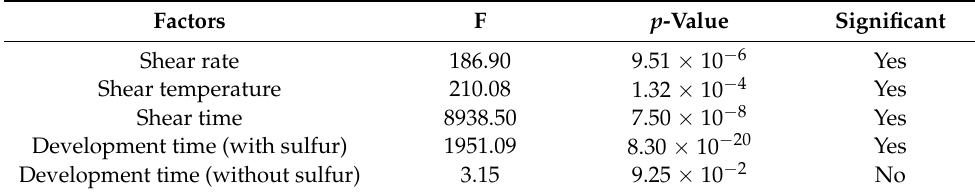
Table 3. ANOVA analysis for each influencing factor. Factors F p -Value Significant Shear rate